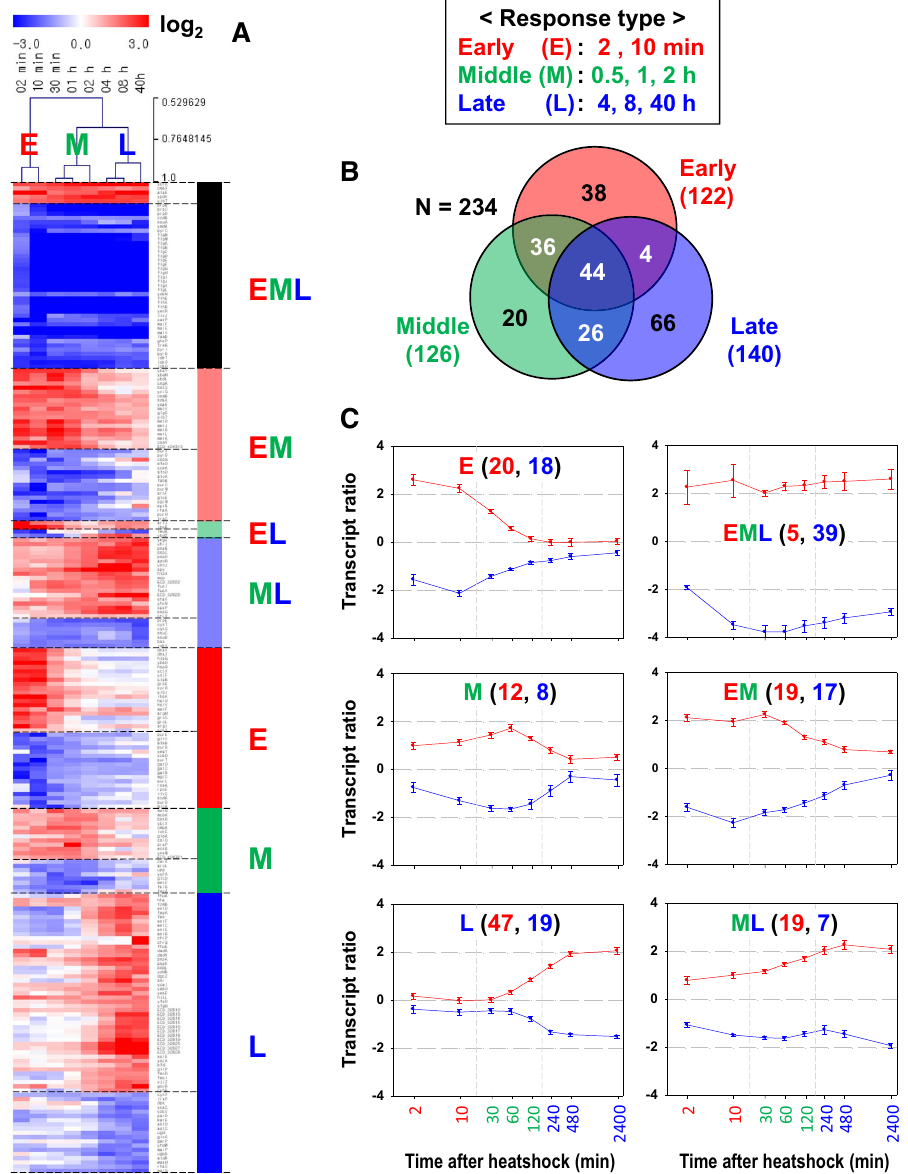
Figure 2. Genes differentially expressed at the early, middle, and late periods of the upshifted temperature. The mRNA log 2 ratios of time-series data were normalized to a sample from pre-perturbation (30 min before the temperature upshift). ( A ) Heatmap of the transcript ratios grouped according to time stages with member genes in rows and sampling time points in columns. Clustering of the sampling time points is shown above the heat map for the early (E), middle (M), and late (L) stages. The image was created with MeV software (version 4.9.0, https ://mev.tm4.org). ( B ) Venn diagram of the differentially expressed genes (DEGs) identified in the different time stages. ( C ) Time profiles of averaged transcript ratios of the DEGs according to the time stage. The X-axis denotes the culture time after the temperature upshift (min in log scale), and the Y axis denotes the log 2 - transformed transcript ratio in reference to the mRNA intensity at 30 min before the perturbation. The error bar denotes the standard error of the mean from the member genes. In each plot, the numbers of upregulated and downregulated genes are depicted in red and blue,